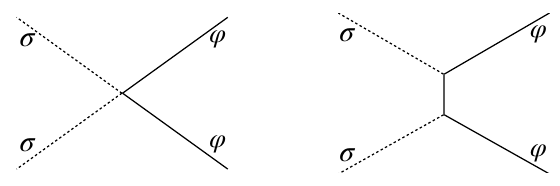
Figure 2 . Feynman diagrams which generate E 2 contributions in σσ → ϕϕ scattering. Four-point